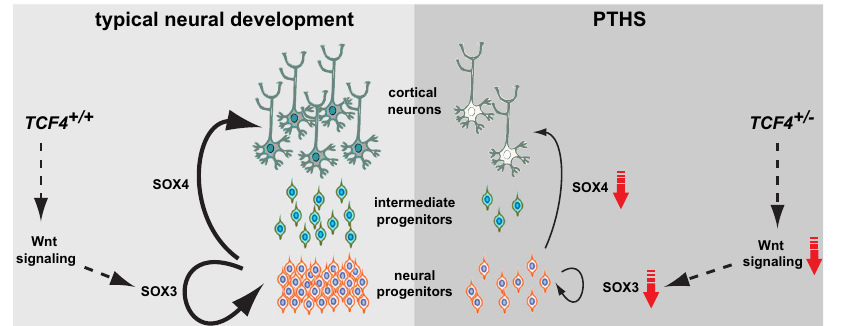
Fig. 10 Model of dysregulated pathways underlying PTHS pathophysiology. Mechanistic model to explain aberrant cellular phenotypes in PTHS neural structures. Due to TCF4 loss-of-function in PTHS, Wnt signaling activity diminishes, in turn leading to decreased SOX3 expression in NPCs, impairing proliferation. Moreover, we observed that SOX4 is also downregulated in PTHS cells, which we suggest impairs neuronal differentiation and content in the PTHS neural